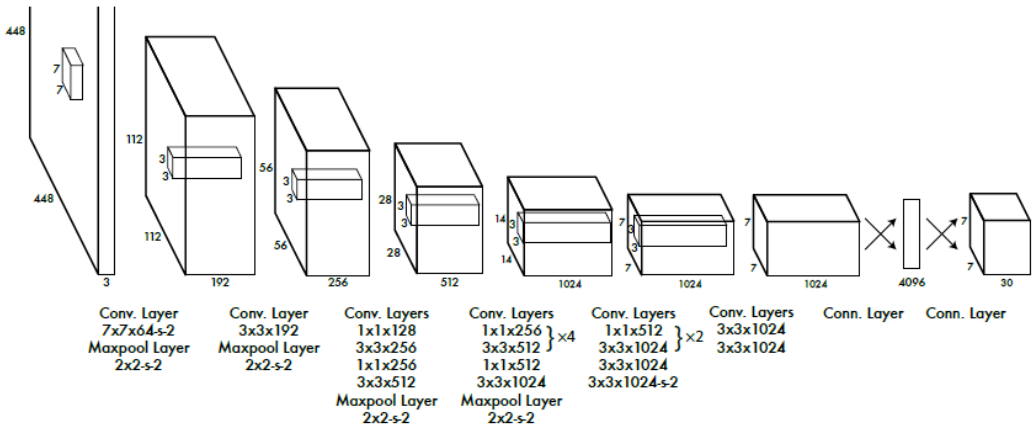
Figure 3. The YOLO network architecture. The detection network has 24 convolutional layers followed by two fully connected layers. Alternating 1 × 1 convolutional layers reduce the features space from preceding layers. We pre-train the convolutional layers on the ImageNet classification task at half the resolution (224 × 224 input images) and then double the resolution for detection.